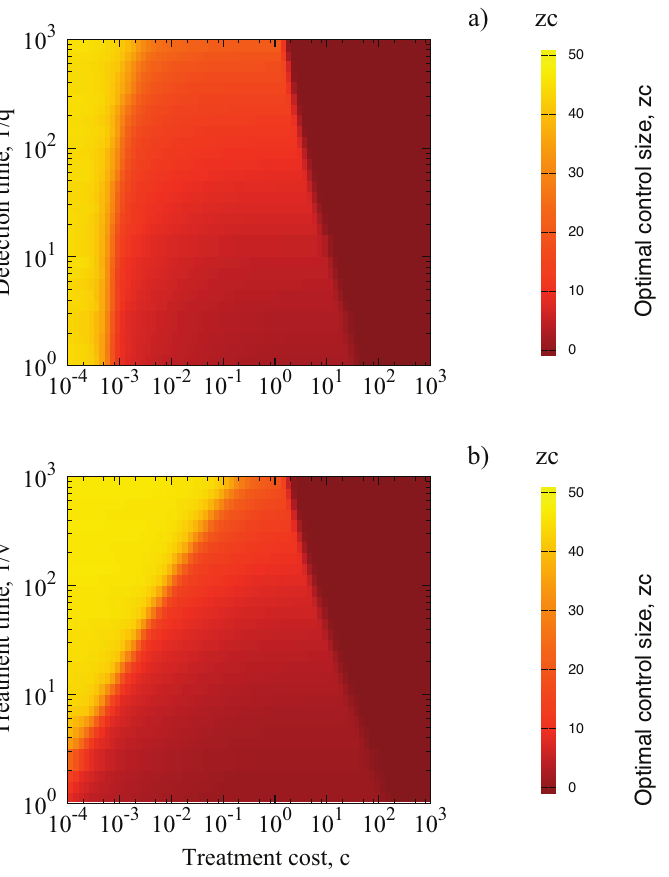
Figure 7. Control neighborhood size as a function of treatment cost c and detection time t q (a) and treatment time t v (b). Simulation parameters: f ~ 1, q ~ 0 : 5, v , r ~ 0 : 1, with 40 initial foci and z inf ~ 1 : Color borderlines between different regions indicate transition regions among various optimal strategies.